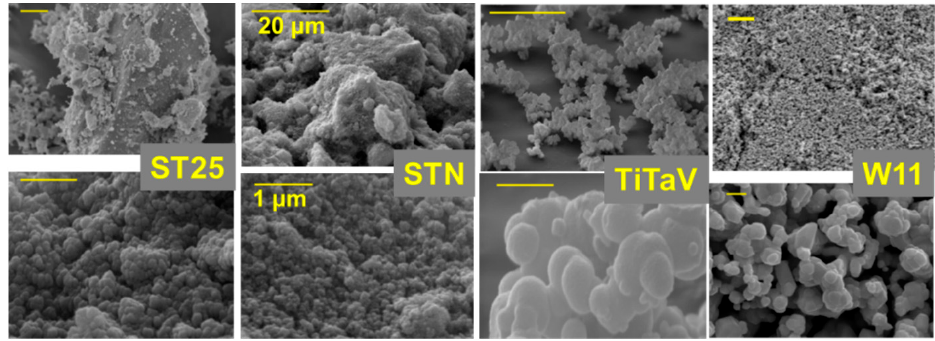
Figure 2. SEM images of nanostructured films. The ST25, STN, TiTaV, and W11 sensor thick films (from left to right) are displayed at low (upper panels) and high (lower panels) magnifications.